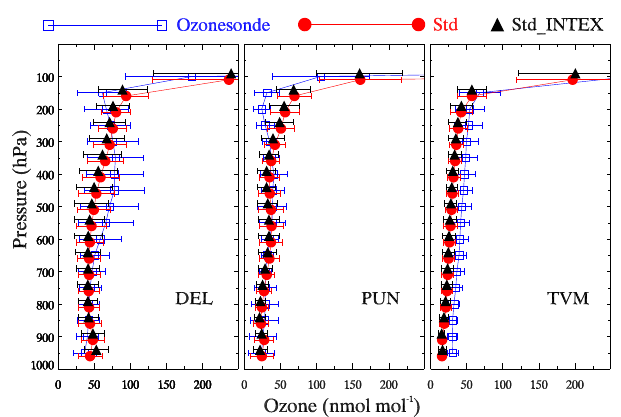
Figure 5. Comparison of average ozone mixing ratios during the summer monsoon (June–September) from Std and Std_INTEX WRF-Chem simulations with the ozonesonde observational clima- tology during 2006–2009 period over Delhi (DEL), Pune (PUN) and Thiruvananthapuram (TVM).